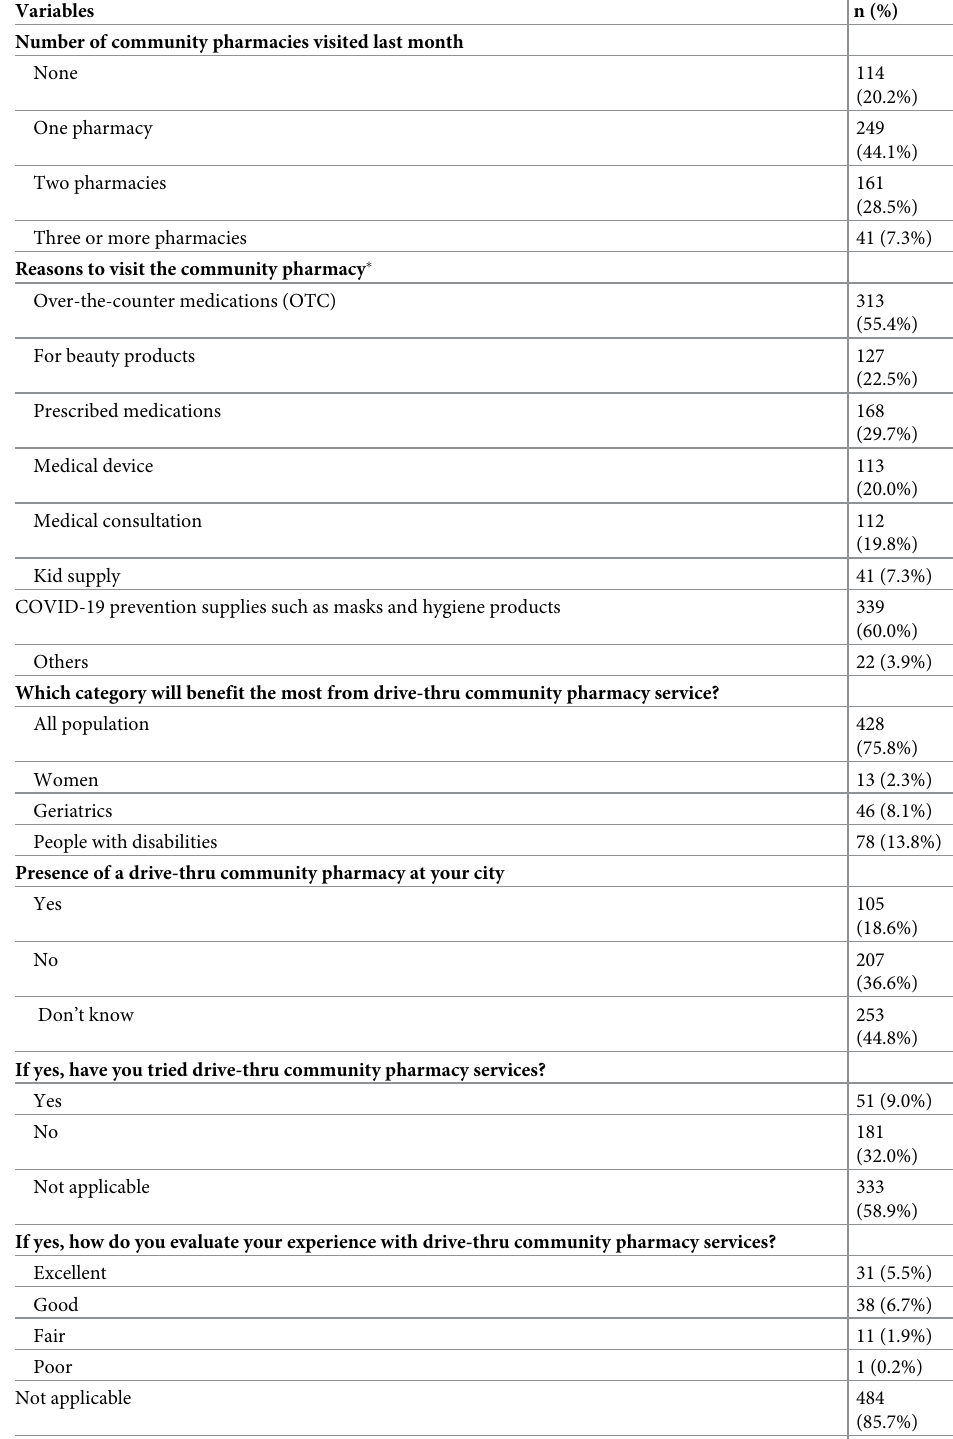
Table 2. Attitudes towards drive-thru community pharmacy services (N =